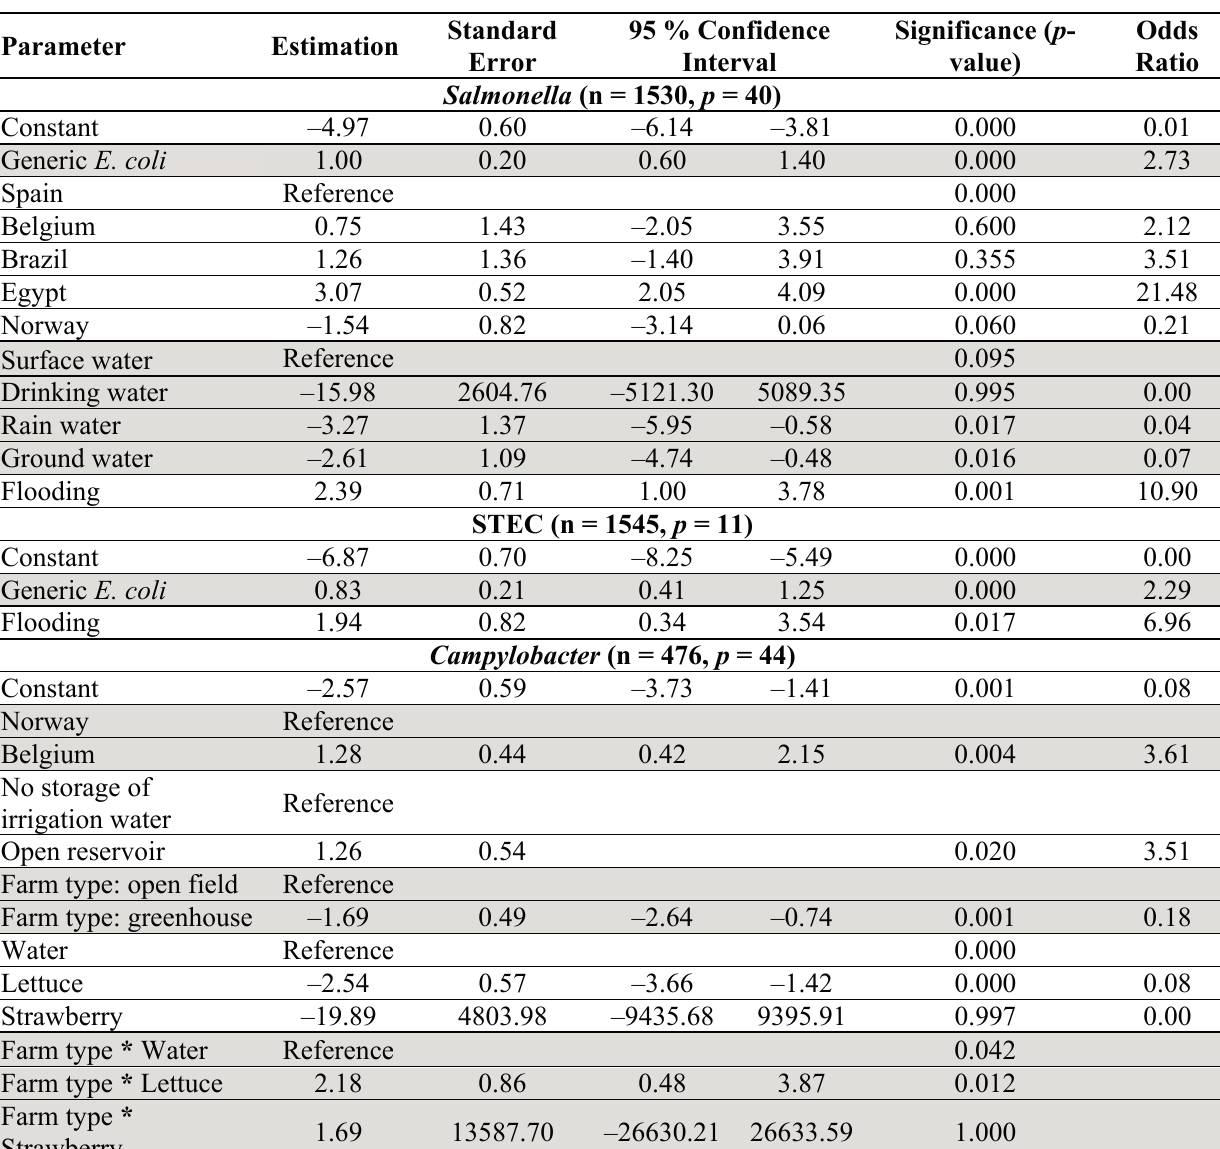
Table 5. Parameter estimates of the predictors in the multiple logistic regression models for the presence (confirmed by culture isolation) of Salmonella , Shiga toxin producing E. coli (STEC) and Campylobacter .